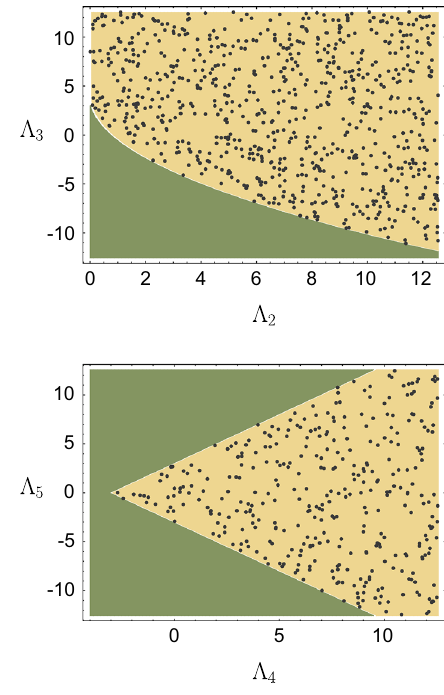
Fig. 1 Exclusionplotfortwoparameterplanes:(i)with (cid:3) 1 = (cid:3) 5 = 5, (cid:3) = 1and(ii)with (cid:3) = (cid:3) = (cid:3) = 1.Thegreenregionisexcluded 4 1 2 3 by analytic constraints, the yellow region is allowed. Black points are allowed according to a parameter scan with BFB